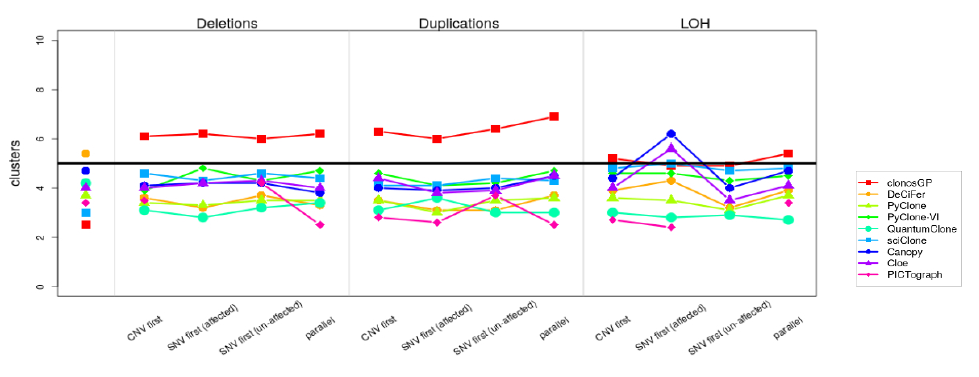
Figure A13. Number of clusters reported using clonosGP, DeCiFer, PyClone, PyClone-VI, Quantum- Clone, sciClone, Canopy, Cloe, and PICTograph in the presence of CNVs. The black line indicates the true number of simulated clones.